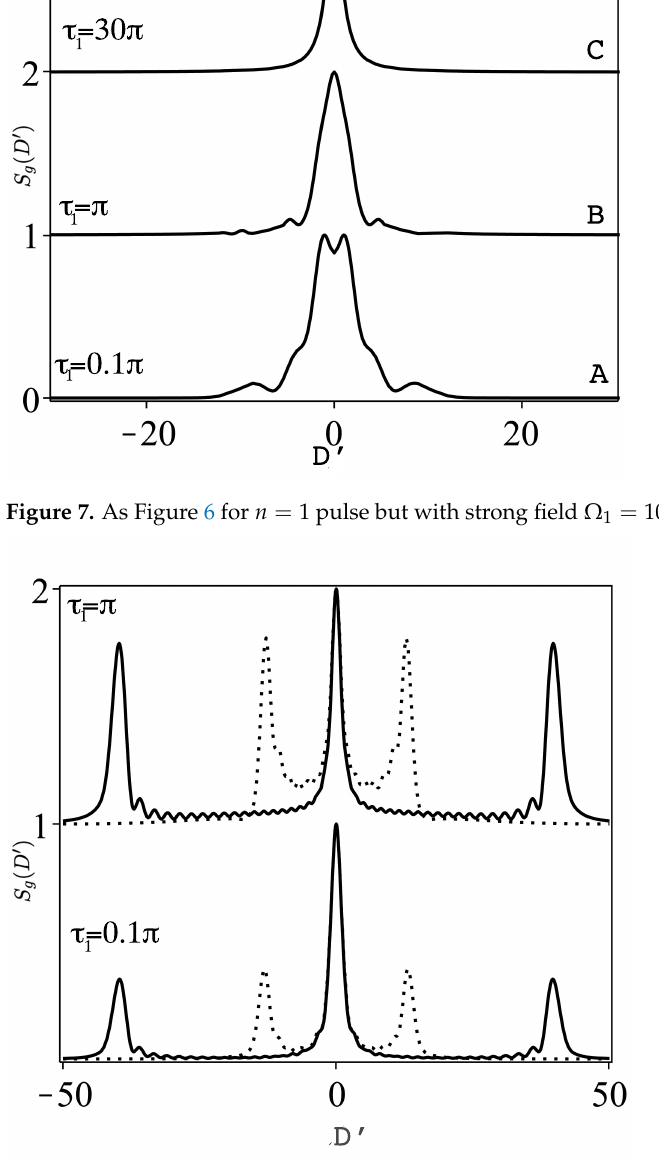
Figure 8. As Figure 7 but for n = 10 pulse and τ R = 0.5 (full lines), 1.5 (dotted lines) for different τ 1